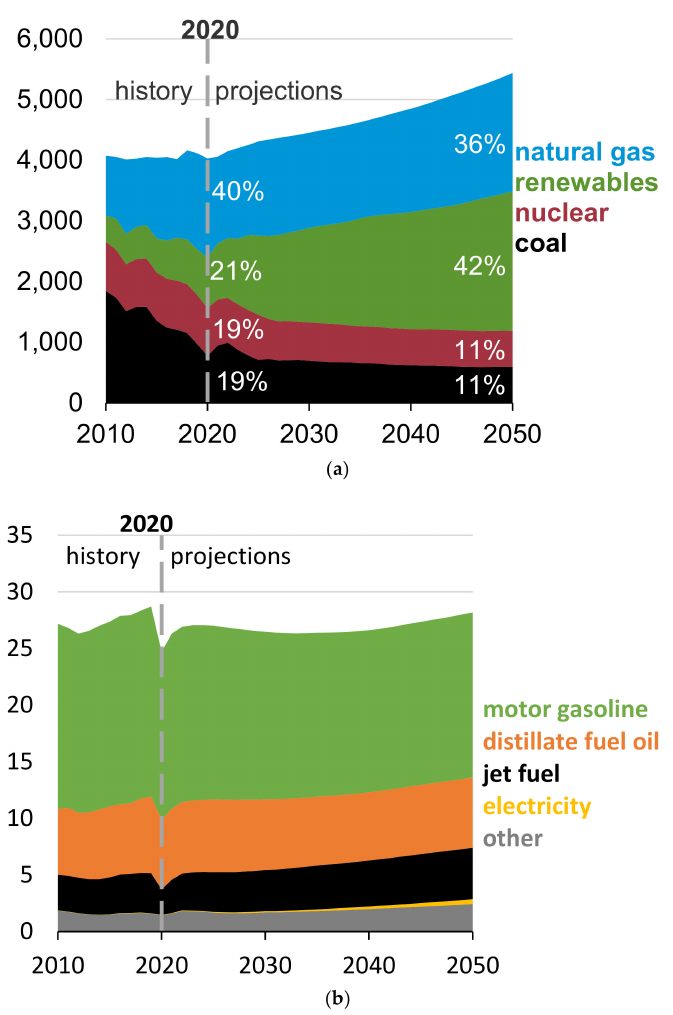
Figure 3. Trends in fuel supply for U.S. electricity production (billion kwh) ( a ) and for fuels for transportation (quads) ( b ). Electrical generation will be dominated by natural gas through 2050; gasoline powered vehicles will continue to power most vehicles through 2050. (Source: EIA